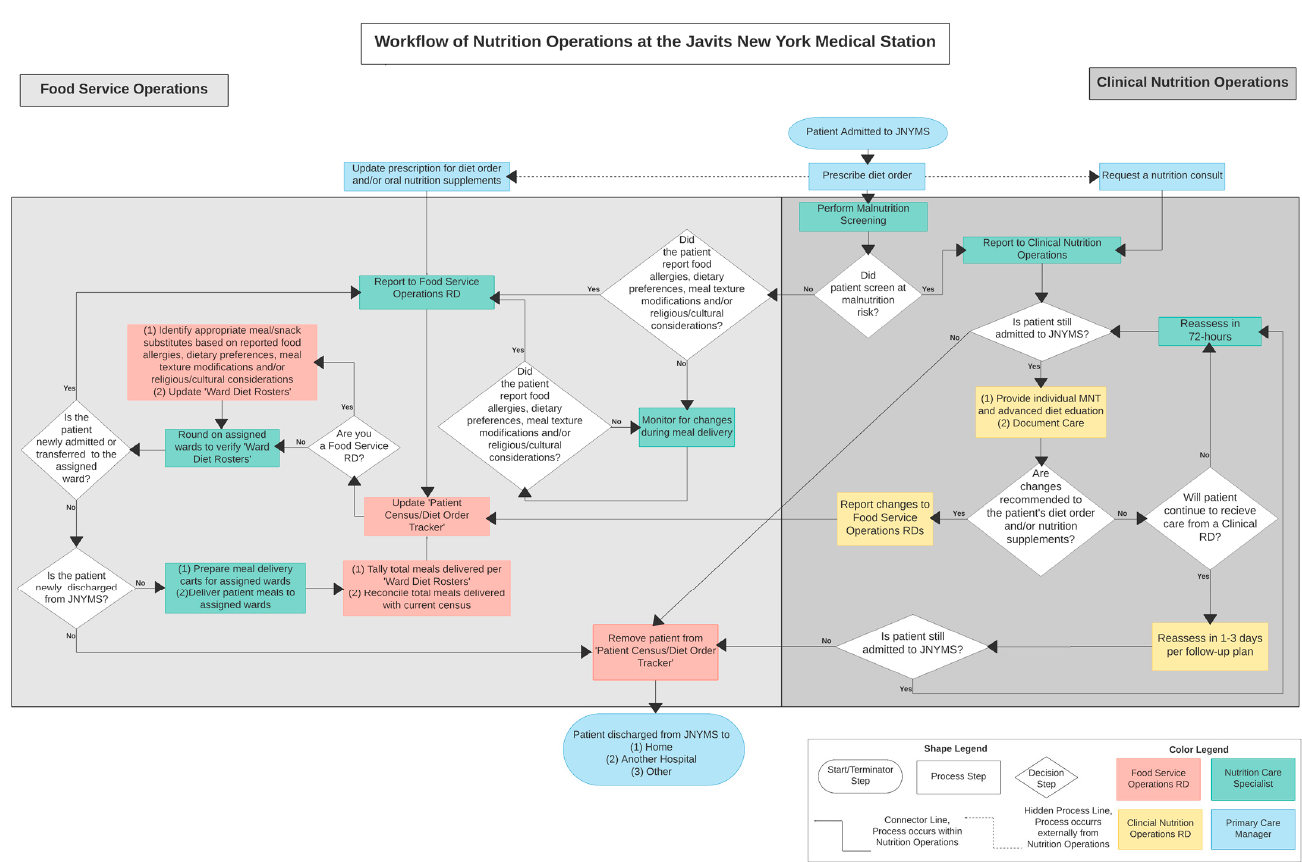
Figure 3. A process-based diagram demonstrating the workflow of food service and clinical nutrition operations at the Javits New York Medical Station performed from 28 April to 1 May 2020.